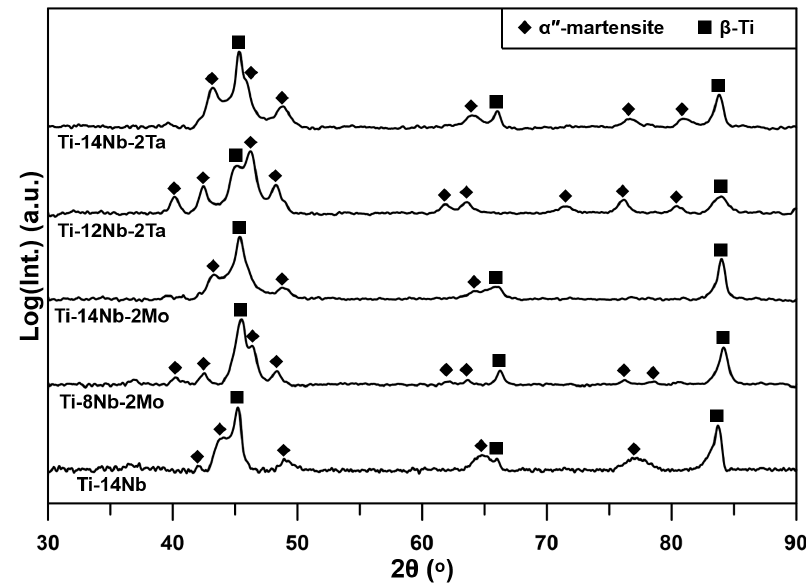
Figure 2. XRD patterns of the investigated materials.